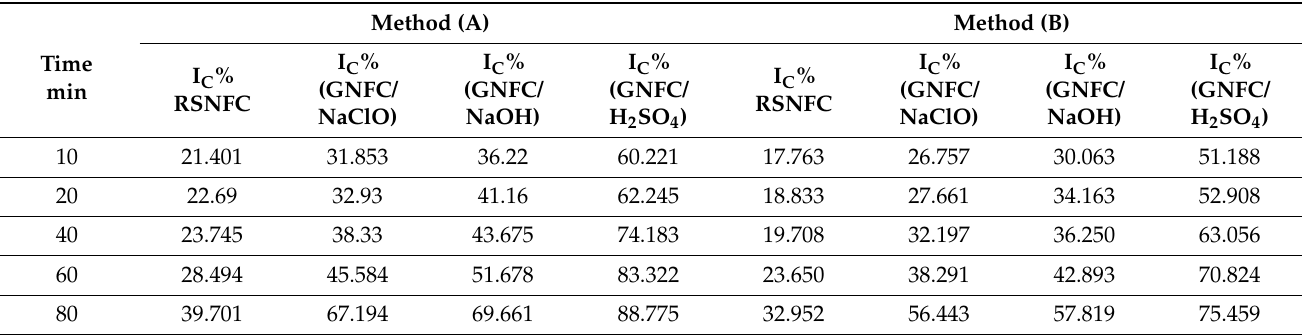
Table 2. Variation of I c for RSCNFC (Real Sample Commercial Nanofiber Cellulose), GNFC/NaClO, GNFC/NaOH, and GNFC/H 2 SO 4 with reaction time using both method A and method